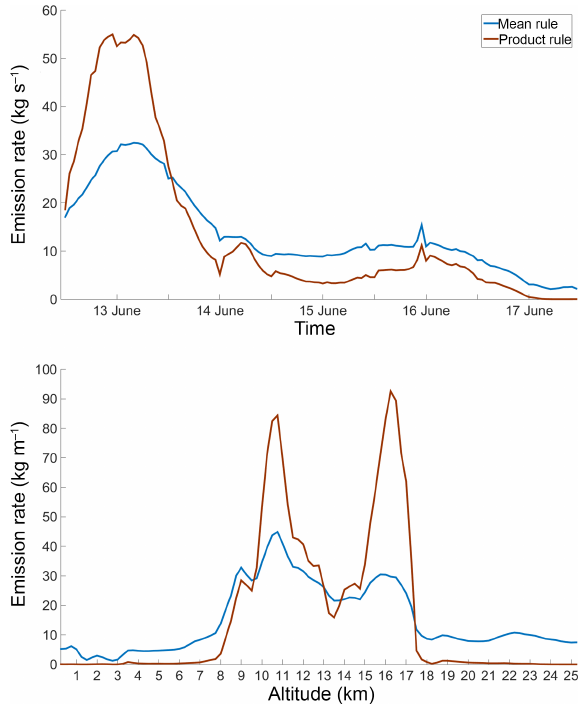
Figure 6. Comparison of reconstructed emission rates integrated over altitude (top) and time (bottom) for the mean rule and the prod- uct rule weight-updating schemes.